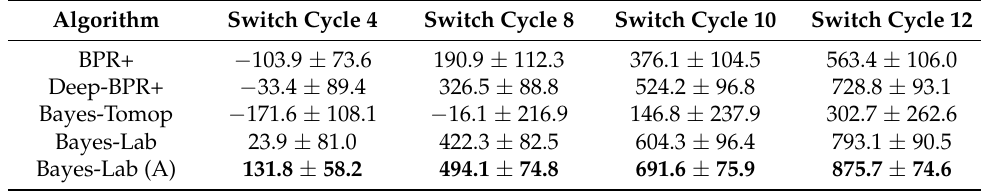
Table 1. The effect of the switching interval on the accumulative